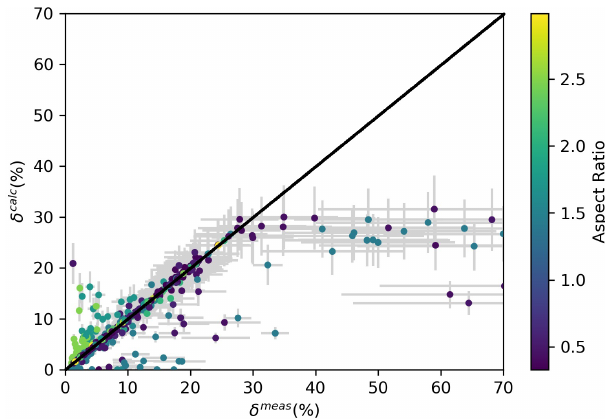
Figure 5. Scatterplot of computed vs. measured particle depolariza- tion δ A . The ARs used for the computations are those that provided the best match between the δ computed and measured values and are represented here by colour coding. Only ARs in the intervals between 0.3 and 0.55 and between 1.5 and 3 have been considered. R th was also selected within the interval 0.5–0.8µm to provide the best match. We report data points with BR greater than 1.2, β cross greater than 5 × 10 − 6 km − 1 sr − 1 and temperature at the observa- tion below